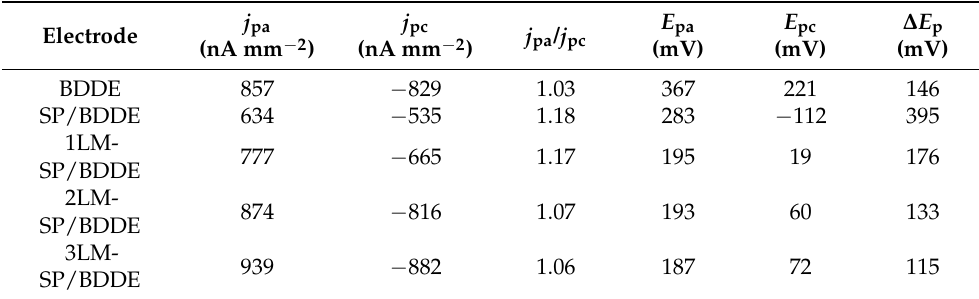
Table 2. Parameters of cyclic voltammograms of redox marker [Fe(CN) 6 ] 4 − /3 − (electrolyte—